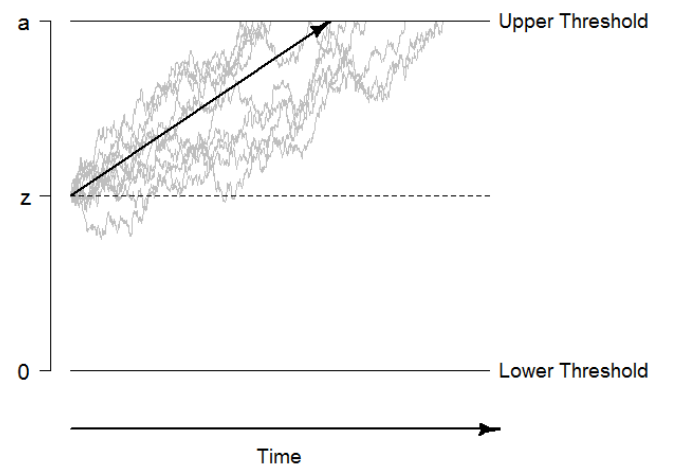
Figure 1. Graphical illustration of the diffusion model. The decision process starts at the starting point z , and information is accumulated until the boundary a is reached. The systematic part of the accumulation process, the drift rate v , is illustrated with the black arrow. The non-decision time t 0 is not included in this